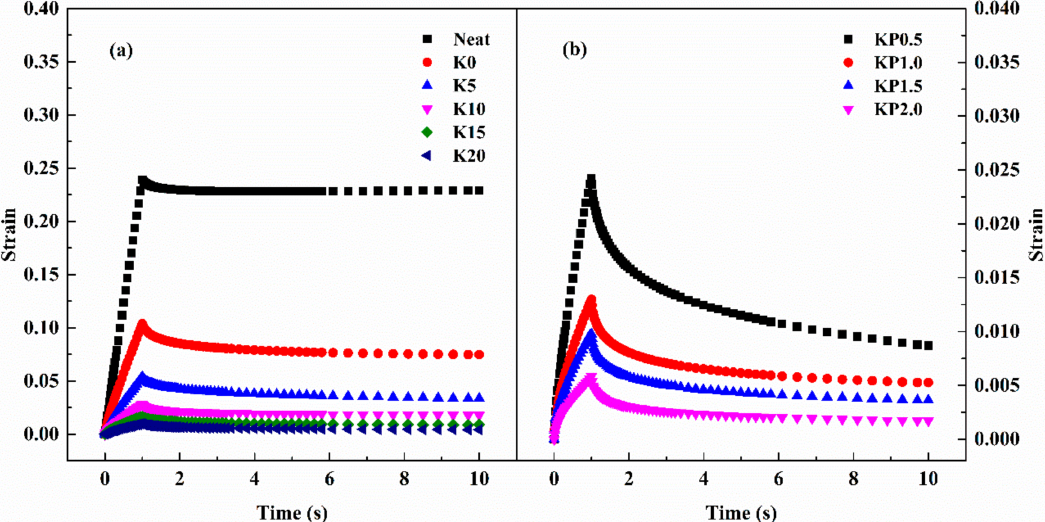
Figure 6. Typical one cycle of creep-recovery at 0.1 kPa and 60 ◦ C: ( a ) SBS/OSDOA-modified asphalts; ( b ) composite modified asphalts.